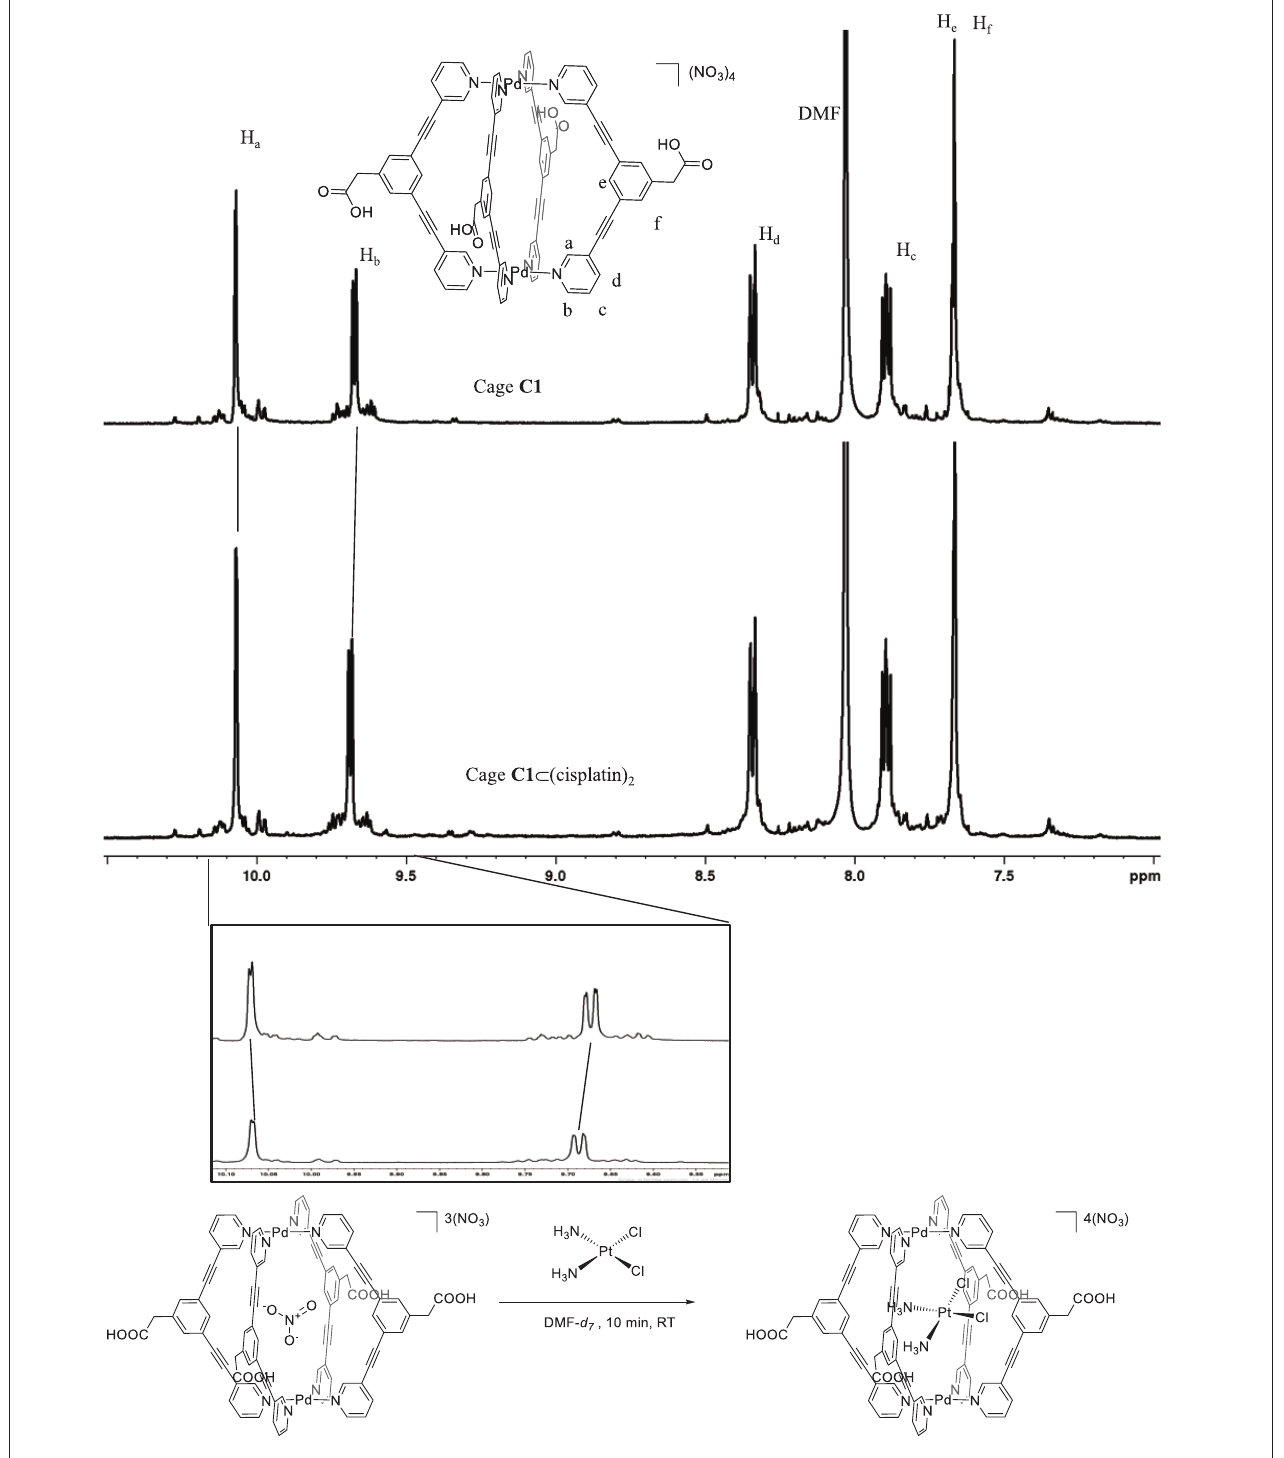
FIGURE 1 | Cisplatin encapsulation in a metallacage following displacement of nitrate ions from the cavity. Stacked spectra of cage C1 in DMF- d 7 (top) and cage C1 after the addition of 2 equation of cisplatin (bottom). Box : Zoom-in of signals for peaks H a and H b with chemical shifts of δ = − 0.002 ppm (upfield) and + 0.01 ppm (downfield),